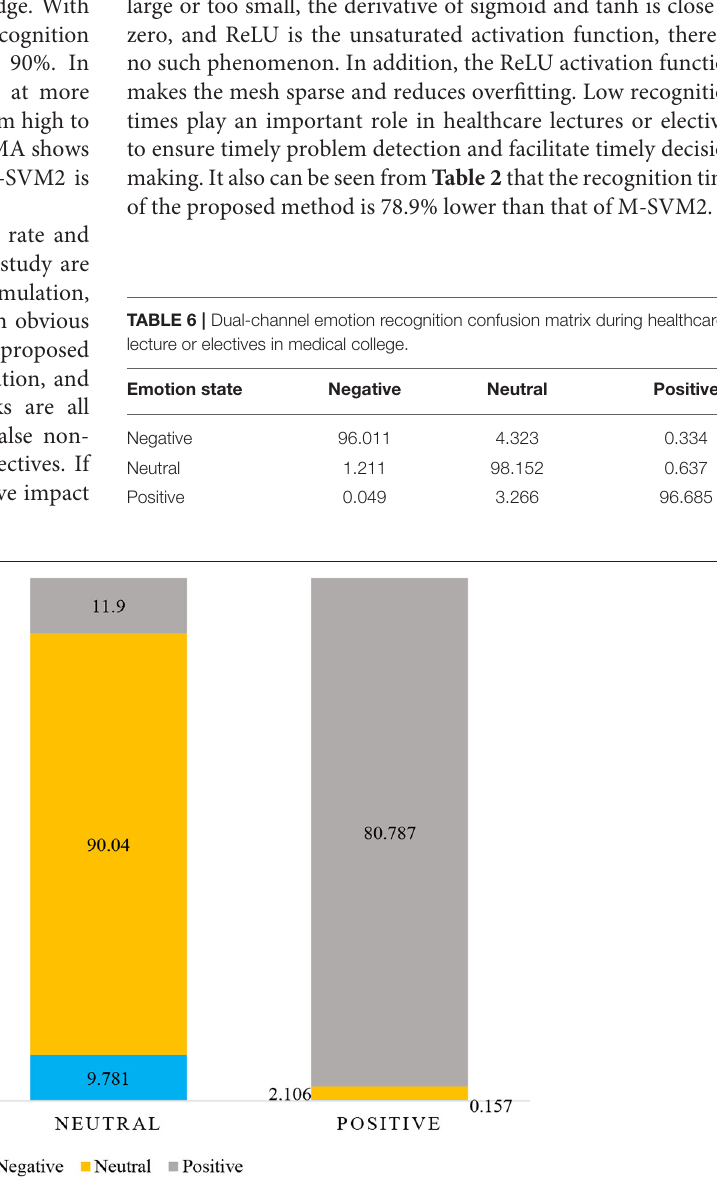
FIGURE 7 | Percentage stacked column chart of posture emotion recognition confusion